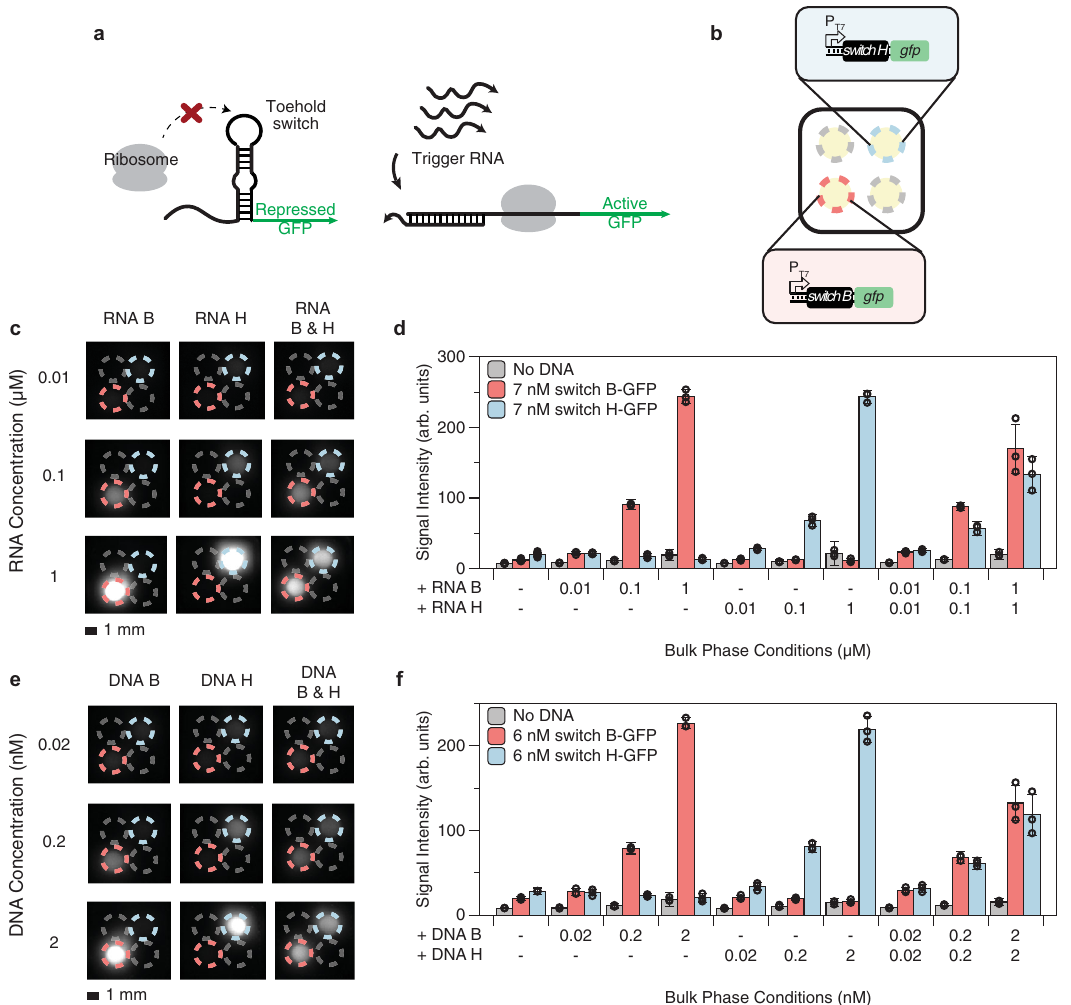
Fig. 4 Simultaneous detection of multiple model nucleic acid sequences in membrane-less protocell arrays. Reactions were incubated at 37 °C for 3 h. a Schematic of toehold switch mechanism. Without trigger RNA, the switch mRNA forms an inhibitory hairpin blocking the translation of a reporter (GFP). Addition of trigger RNA unwinds the switch hairpin, allowing GFP translation. b Schematic of protocell array setup for simultaneous detection of multiple nucleic acid sequences. Red and blue circles indicate micro-basins containing toehold switches B and H, respectively. Gray circles indicate CFE protocells without plasmids. c Representative fl uorescence image of RNA detection from 10 nM to 1 µ M. Images in the same column have the same RNA trigger(s) added. Images in the same row have the same concentration of trigger(s) added. Circle colors are as shown in b . d Quanti fi cation of fl uorescence images in c and their replicates. Addition of both RNA triggers mutually represses their outputs, but this effect is speci fi c to these triggers. e Representative fl uorescence image of linear DNA detection from 20 pM to 2 nM. Images in the same column have the same DNA trigger(s) added. Images in the same row have the same concentration of DNA trigger(s) added. Circle colors are as shown in b . Addition of both DNA triggers also mutually represses their outputs. f Quanti fi cation of fl uorescence images in e and their replicates. For experiments where the bulk phase had no triggers, data are presented as mean values ± SD of 27 replicates for protocells containing toehold switch sensors (9 biological replicates × 3 technical replicates) and 54 replicates for reactions with no DNA (9 biological replicates × 6 technical replicates). For experiments with triggers (RNA or DNA), data are presented as mean values ± SD of 9 replicates for protocells containing toehold switch sensors (3 biological replicates × 3 technical replicates) and 18 replicates for reactions with no DNA (3 biological replicates × 6 technical replicates). Hollow circles represent the mean of each biological replicate. Scale bar is 1 mm. Data for each biological replicate are provided in Supplementary Figs. 4 and 5. Details on CFE lysate used, plasmid concentrations, and reaction additives are provided in Supplementary Table